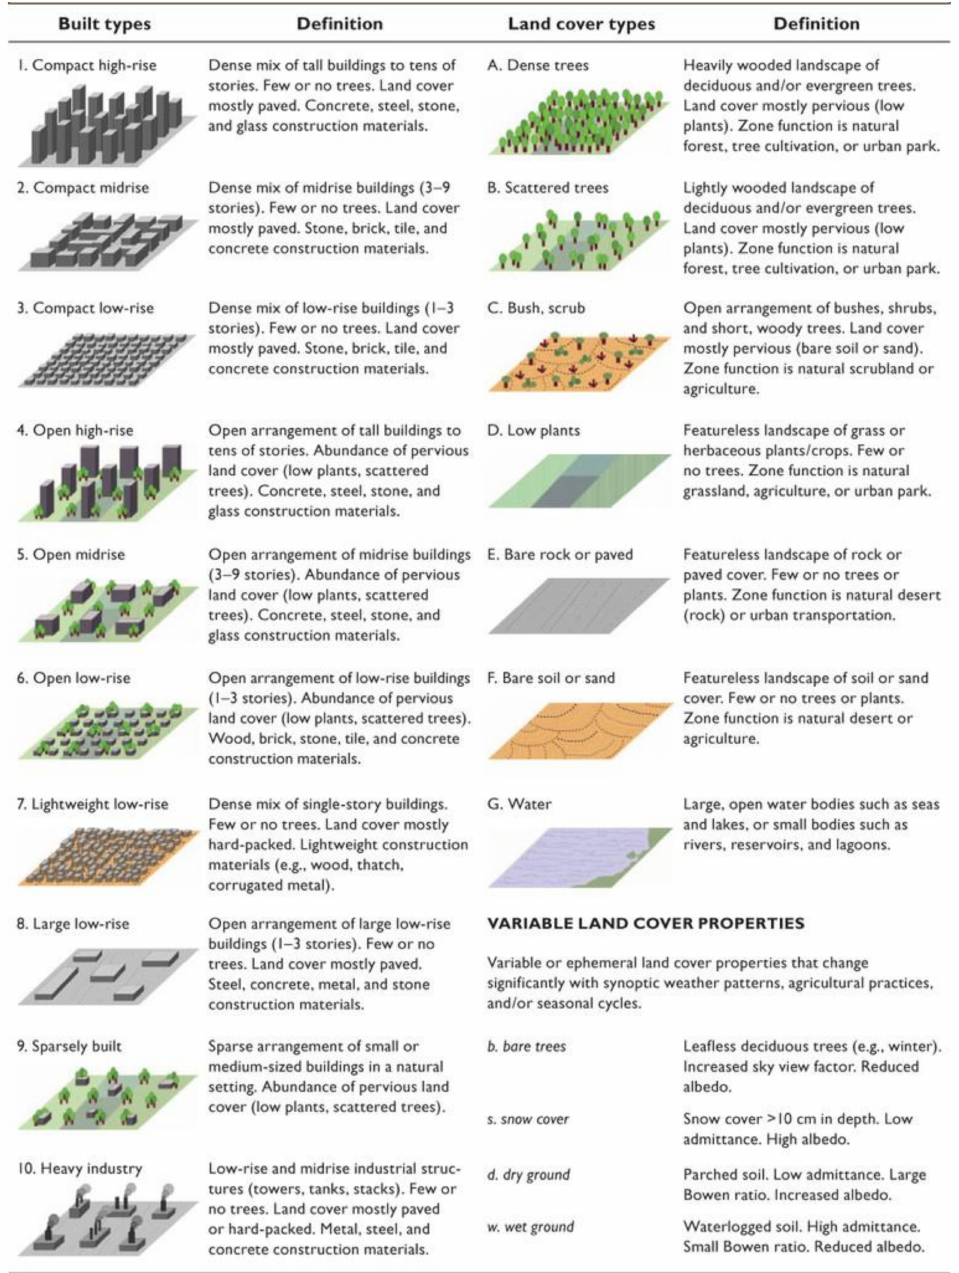
Figure 1. Building and land cover types in the local climate zone (LCZ) classification system of Stewart and Oke